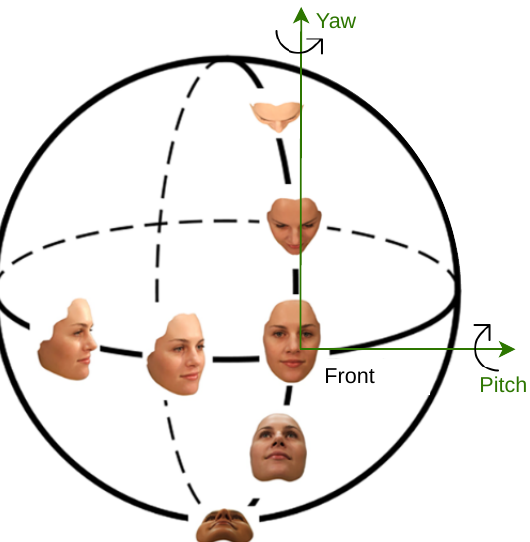
Figure 2. Influence of yaw and pitch angles variations on the head pose, showing that pitch angle have the great impact on the face features. Moving away from the front pose resultant on less distinctive